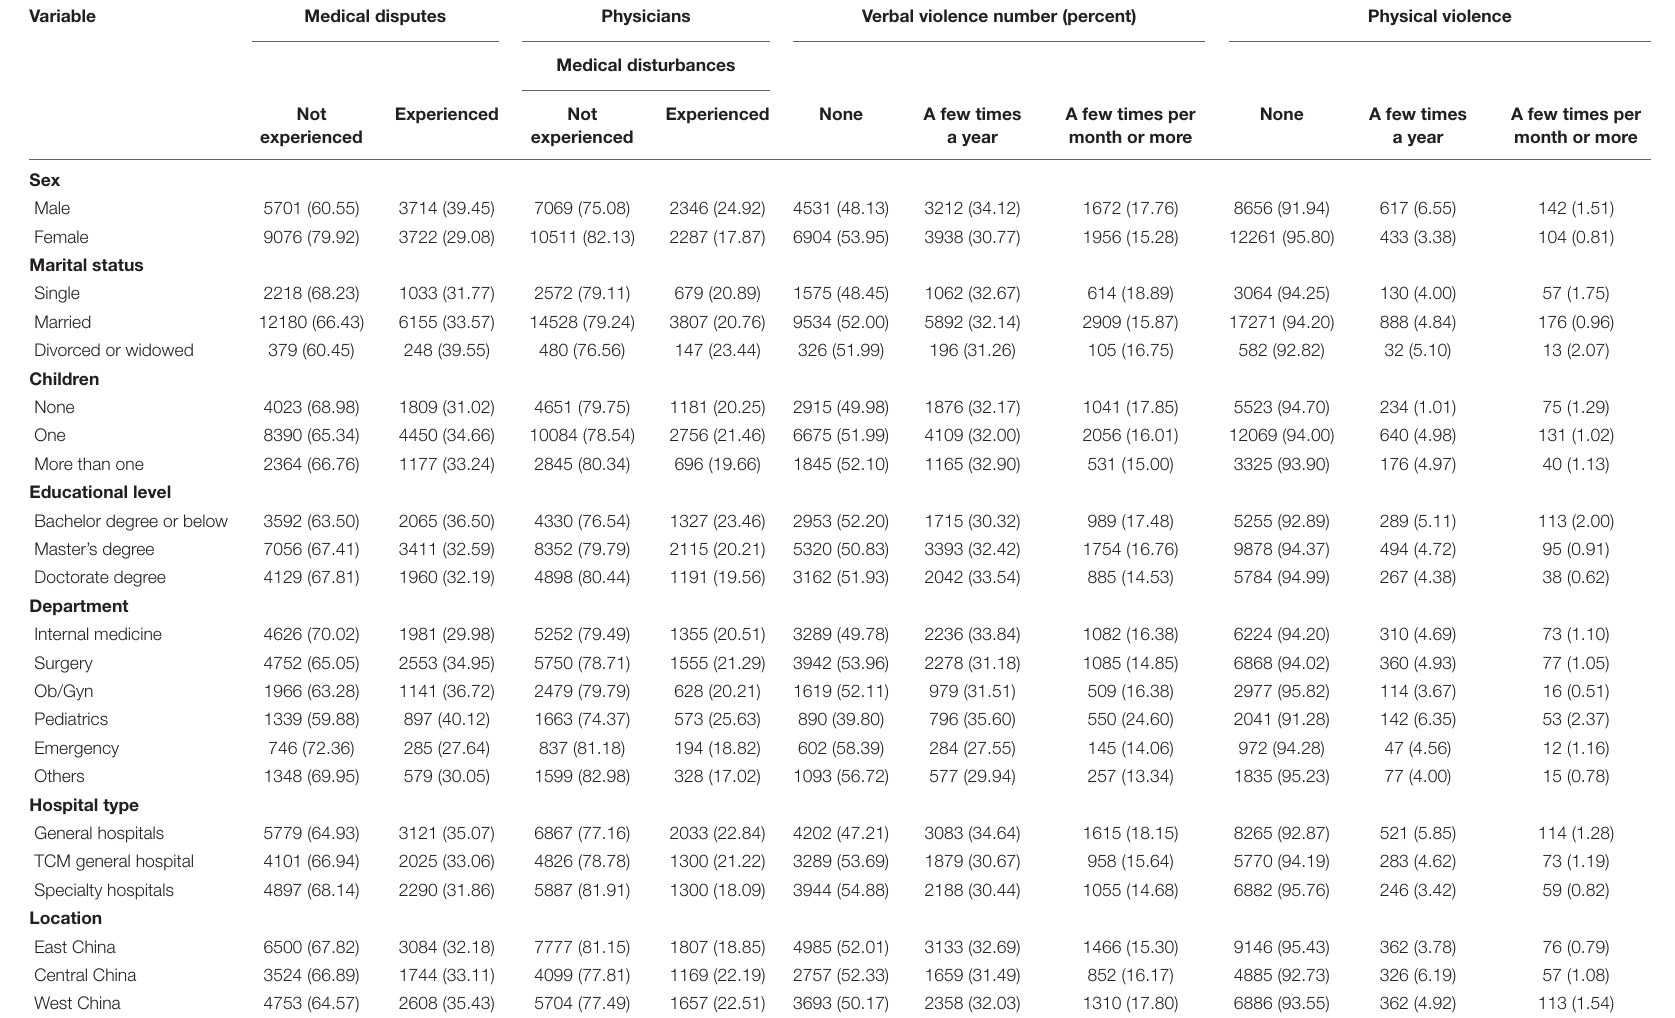
TABLE 5 | Distribution of medical disputes, medical disturbance, verbal and physical violence among